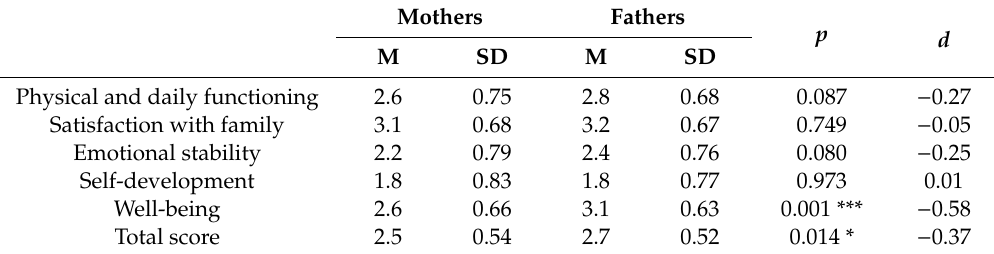
Table 2. Comparison of quality of life (QoL) between mothers and fathers of children and adolescents with rare diseases requiring mechanical long-term